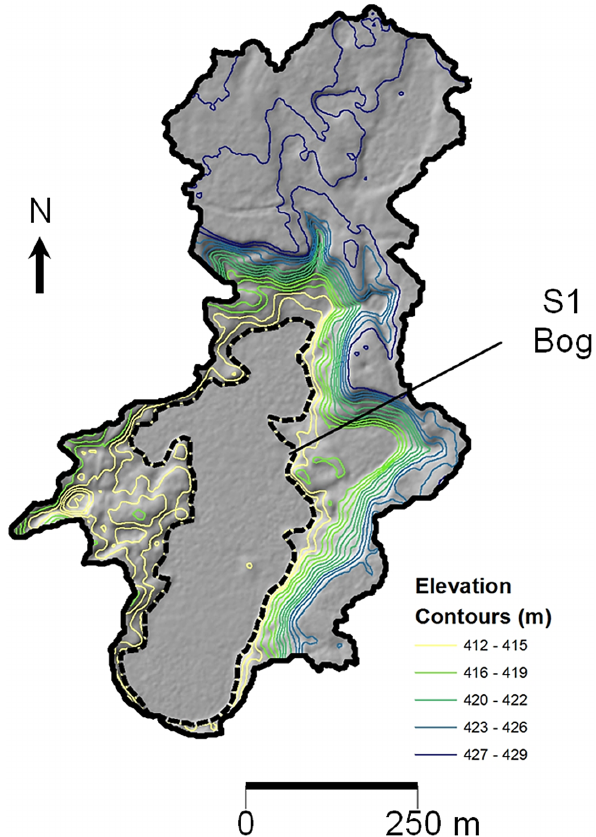
Figure 1. The topography of the S1 Watershed on the Marcell Ex- perimental Forest, which contains the S1-Bog